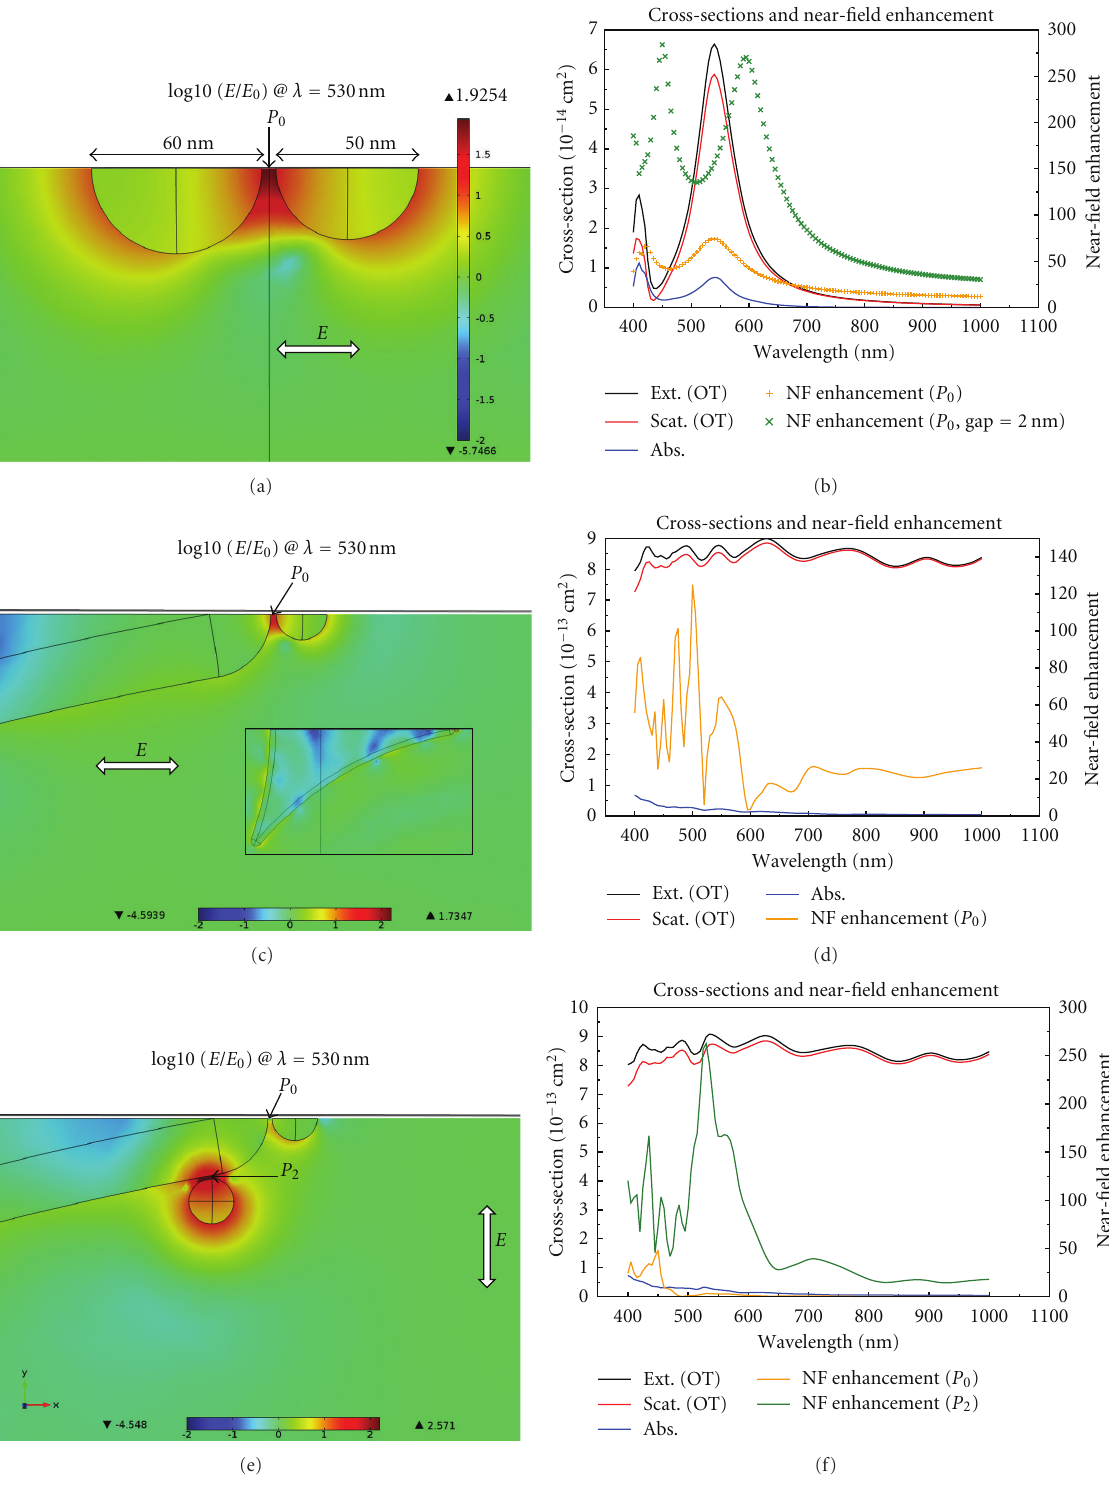
| E / E | in the symmetry plane of nanoparticles (left column) and extinction, scattering, absorption cross-section and near-field Figure 2: log 0 10 enhancements spectra (right column). (a) and (b) Two Ag spheres of 60 nm and 50 nm diameter, separated by a gap of 5nm. The near-field at the gap middle point ( P 0 ) marked with × was calculated for a gap of 2 nm. (c) and (d) triangular particle (thickness 50 nm) and small sphere of 20 nm diameter. Gap between the particles is 2nm. The insert shows half of both particles. (e) and (f) triangular particle and three small spheres of 20 nm diameter (only half geometry is presented in (e)). Gap between triangular particle and each sphere is 2nm. In all configurations, the refractive index of medium is n = 1 .